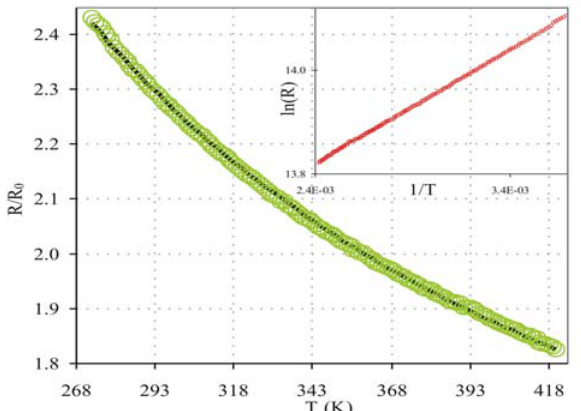
Figure 10. Resistance vs . temperature for SWCNTs deposited on electrodes connected to the amplifier. Line is fit to the data obtained from Equation (1) with fit parameters: T = 277 K and T = 40 K. The inset shows the data in a Ln(R) vs. 1/T 1 0